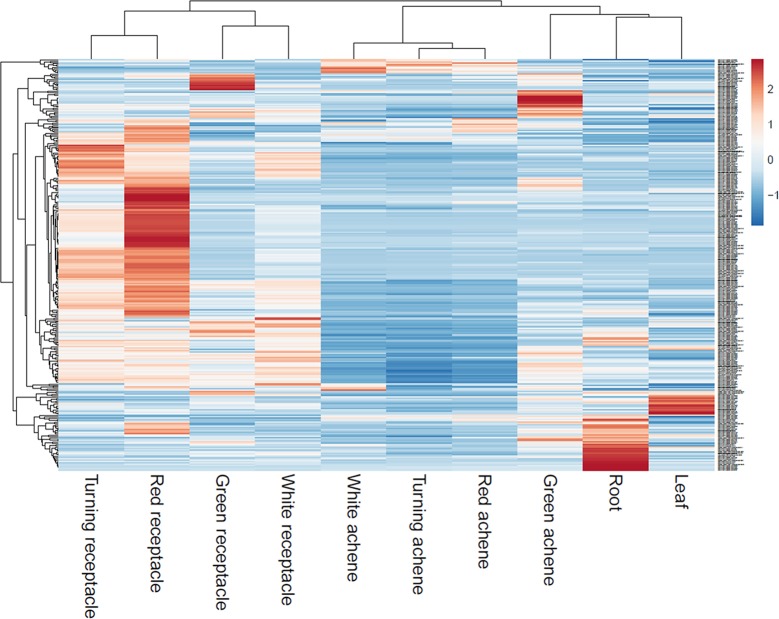
Transcript accumulation of fruit eQTL genes across various tissues. Scaled heatmap of gene expression reveals fruit eQTL genes are predominantly or exclusively expressed in the later fruit stages.